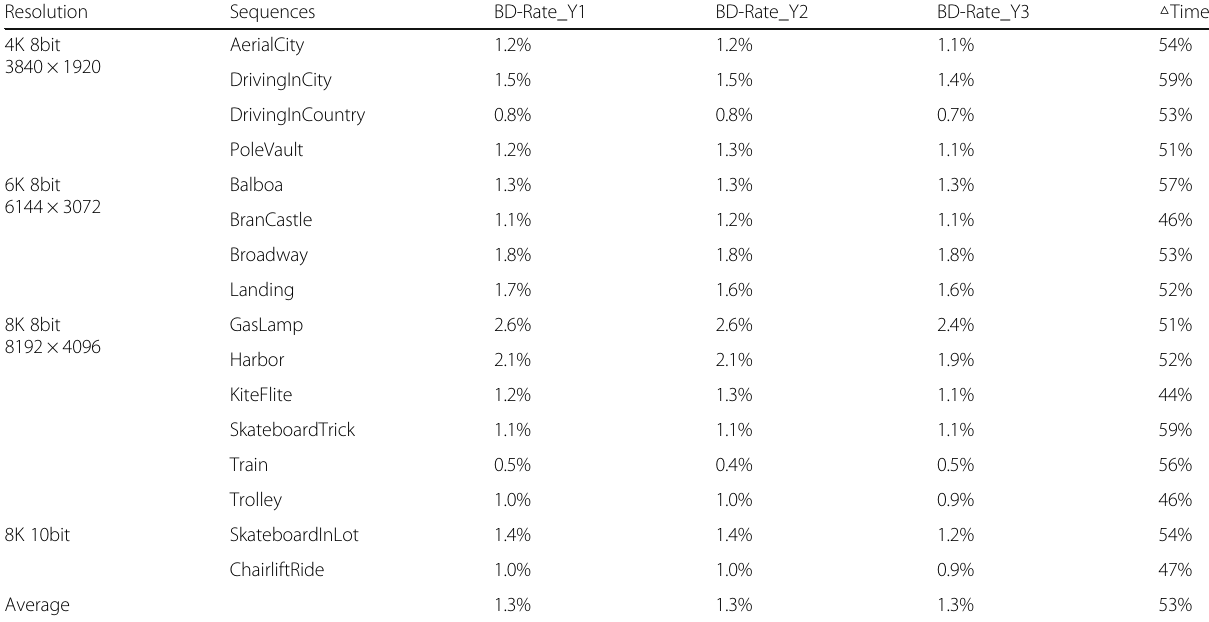
Table 7 Performance comparison between the original HM 16.16 and the proposed overall algorithm Resolution